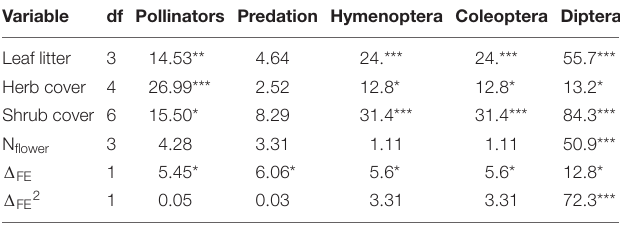
TABLE 2 | Generalized linear modeling (Poisson error structure, linear link function) detected significant influences of important categorical habitat structures (leaf litter, herb, and shrub cover) on pollinator abundances but not on predation pressure (number of bite marks). Variable